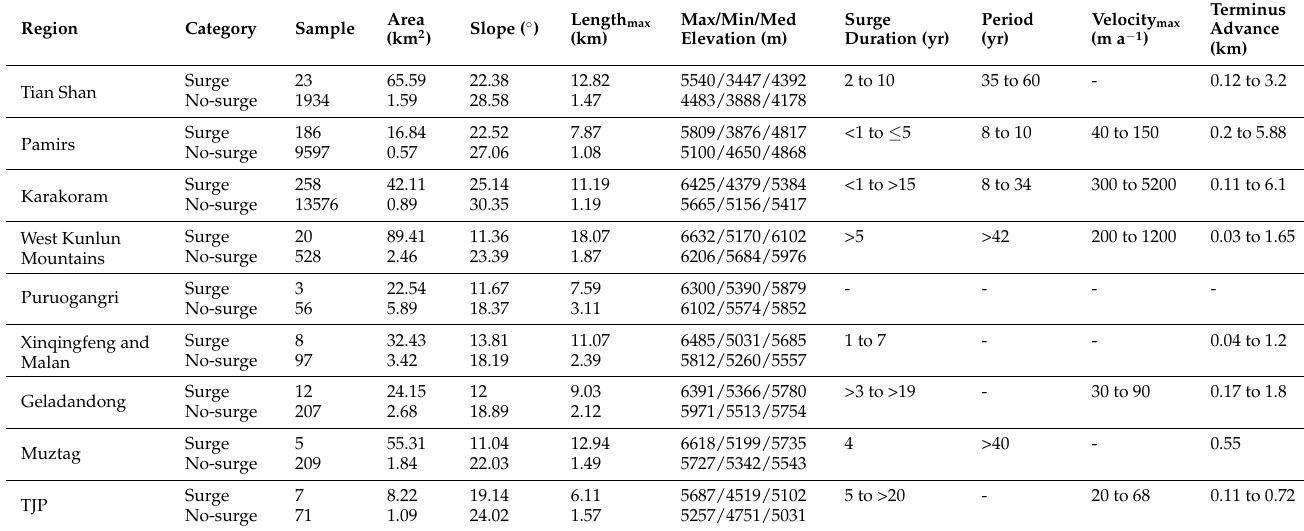
Table 6. Averaged geometric information (area, slope, maximum length, and maximum/minimum/ medium elevation) of glaciers in nine surging regions and the summary of the surge duration, period, maximum velocity (m a − 1 ), and terminus advance (km) for STGs in different regions of HMA [3,8–11,15,25,32–34]. We use the symbol-when no values are